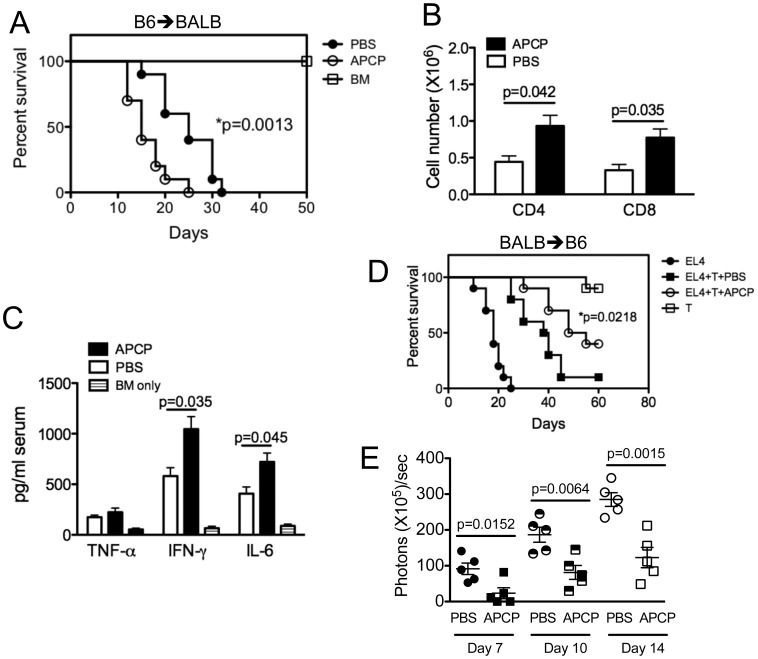
Blockade of CD73 enzymatic activity using the CD73-selective inhibitor APCP exacerbates GVHD but enhances GVL effects.(A) Lethally irradiated BALB/c mice were given i.v. injections of 5×106 T cell depleted BM cells from B6 mice donors alone (n = 5) or with 2×107 splenocytes from WT B6 donors. In the groups receiving T cell transfer, the mice were treated with PBS or APCP 20 mg/kg i.v. twice weekly following donor BM and T cell transfer. (B) Enriched B6 WT T cells were injected i.v. into lethally irradiated BALB/c mice at 2×106 per mouse, and cell expansion was determined 14 days after cell transfer. Mean of absolute number of CD4+ or CD8+ cells per spleen was shown in recipients given donor (H-2Kb+) T cells (n = 5). (C) Indicated cytokines were measured in recipient serum on day 14 after donor BM and T cell transfer as described above (n = 5). (D) Lethally irradiated B6 mice (8–10 per group) were given i.v. injections of 5×106 T cell-depleted BM cells from BALB/c mice donors alone or with 106 BALB/c splenic T cells. In the groups receiving T cell transfer, the mice were treated with PBS or APCP 20 mg/kg i.v. twice weekly following donor BM and T cell transfer. Recipient mice were given 105 EL4-luc lymphoma cells as a separate i.v. injection at the same time of transfer. The recipient mice were monitored daily for survival. (E) The average of relative bioluminescence signal intensity of 5 mice per group at different time points as indicated was shown. P values indicate the differences between control PBS versus APCP treatment. Data are given as means ± SEM.